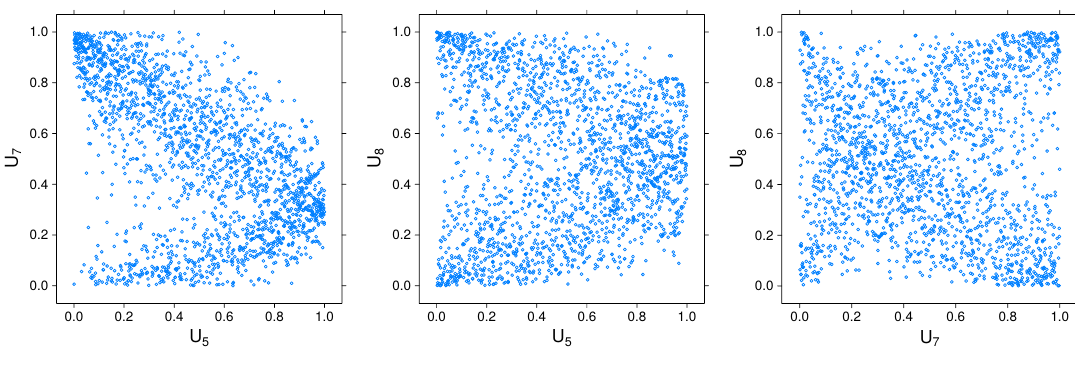
Figure 5: Scatterplots of pseudo observation ranks for pairs (left) fConc1 ( U 5 ) and fM3Long ( U 7 ), (middle) fConc1 ( U 5 ) and fM3Trans ( U 8 ) and (right) fM3Long ( U 7 ) and fM3Trans ( U 8 ) from the MAGIC data set ( n = 2000